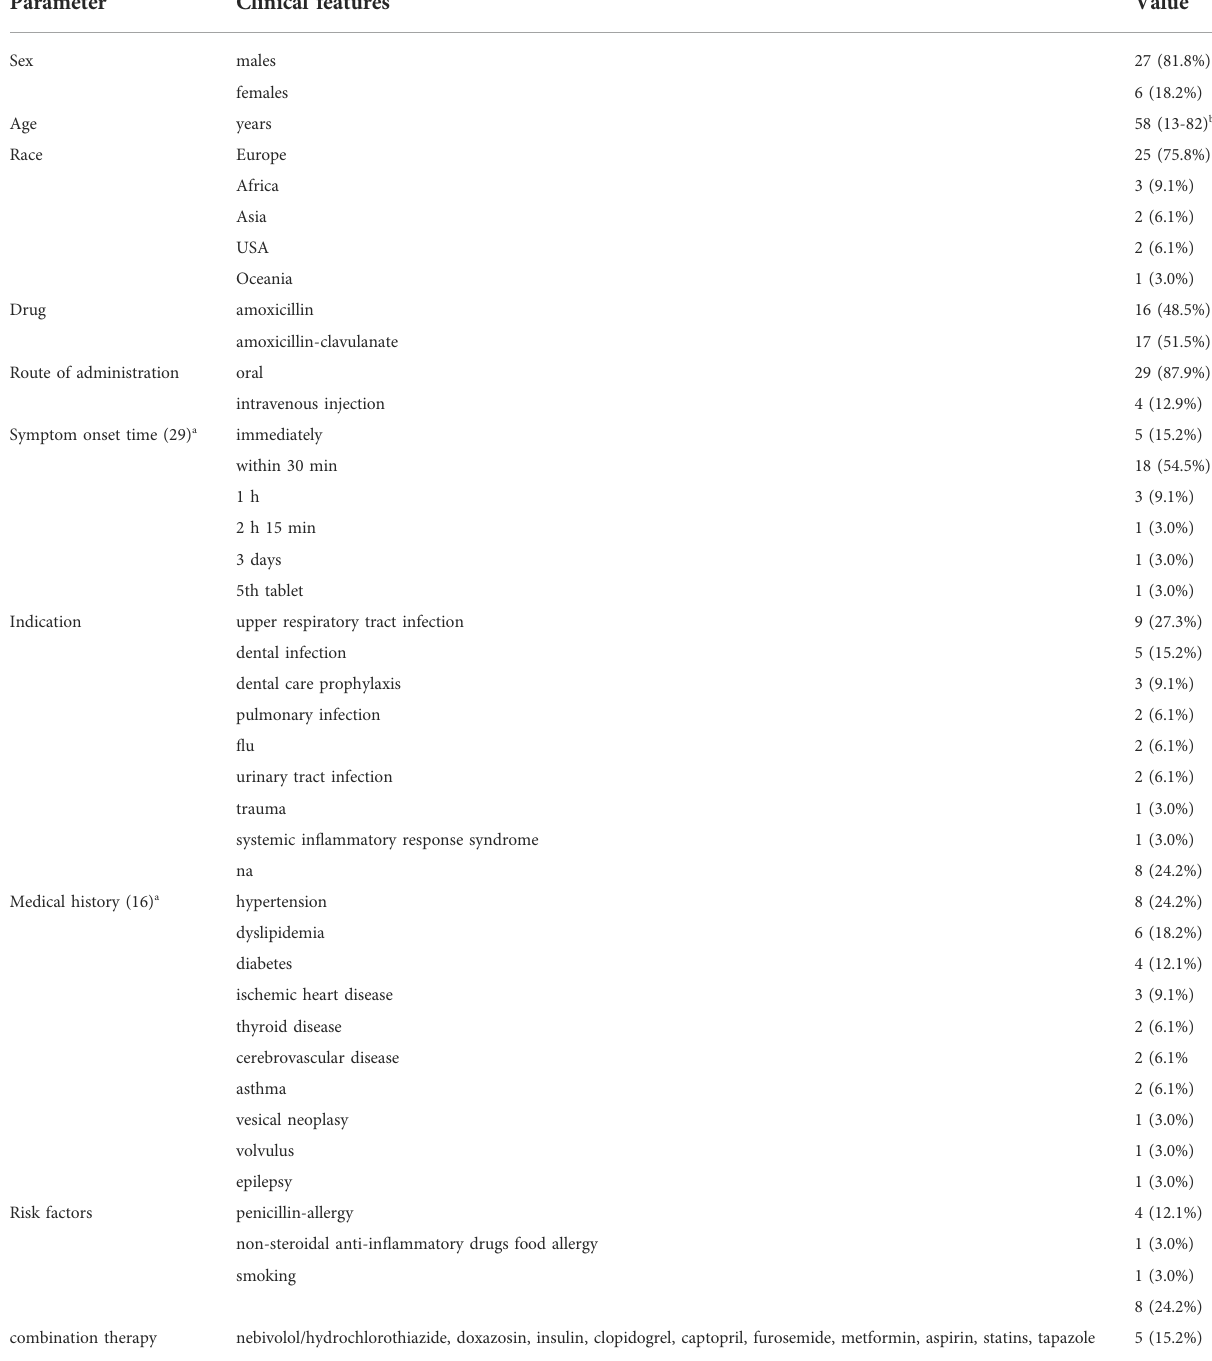
TABLE 2 Basic information of 33 patients with amoxicillin-induced Kounis syndrome.